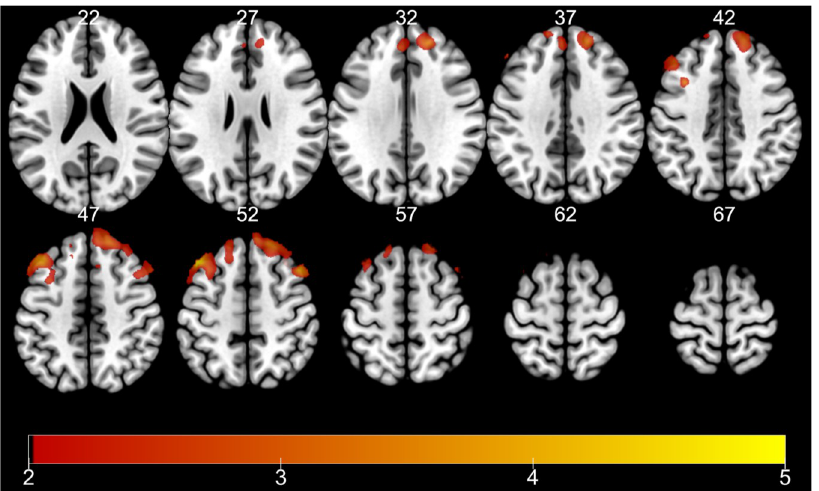
Fig 6. fMRI results: HITs showing commensurate activation with TD during remote retrieval. Color bar indicates t-statistics.